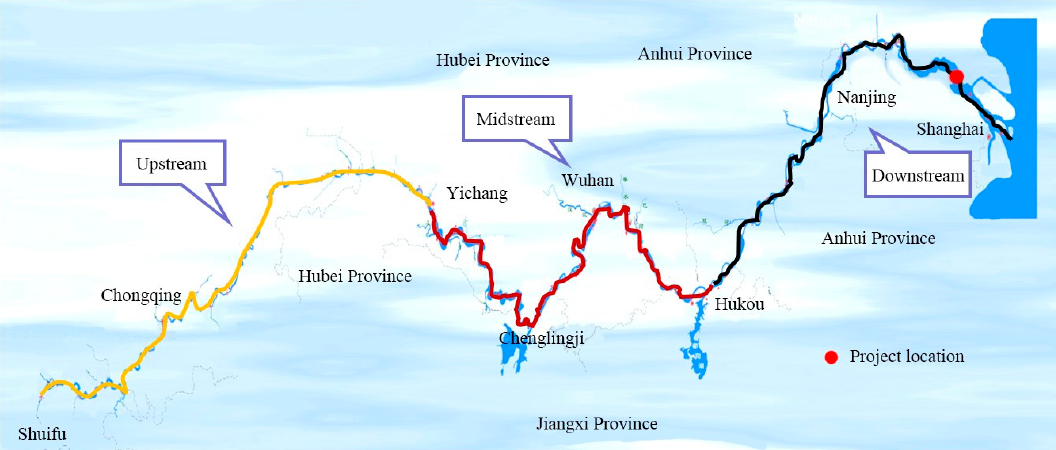
Figure 3. The main channel of the Yangtze River (from Shuifu to the estuary of the Yangtze River).